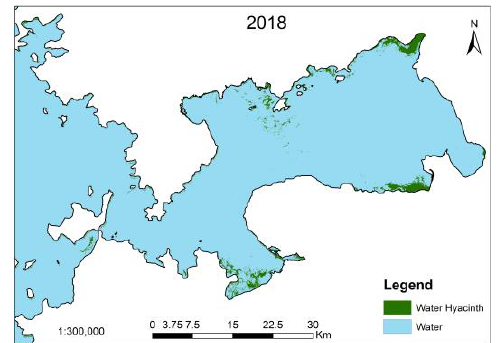
Figure 2 : Shows the extent and the location of water hyacinth weed in January of 2017.